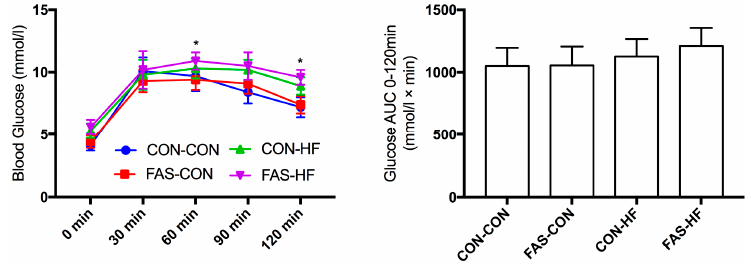
Figure 2. Blood glucose concentrations and the area under curve of blood glucose during oral glucose tolerance test. Values are means with standard deviations ( n = 10). * The difference between FAS-HF and FAS-CON/CON-CON is significant, p < 0.05.